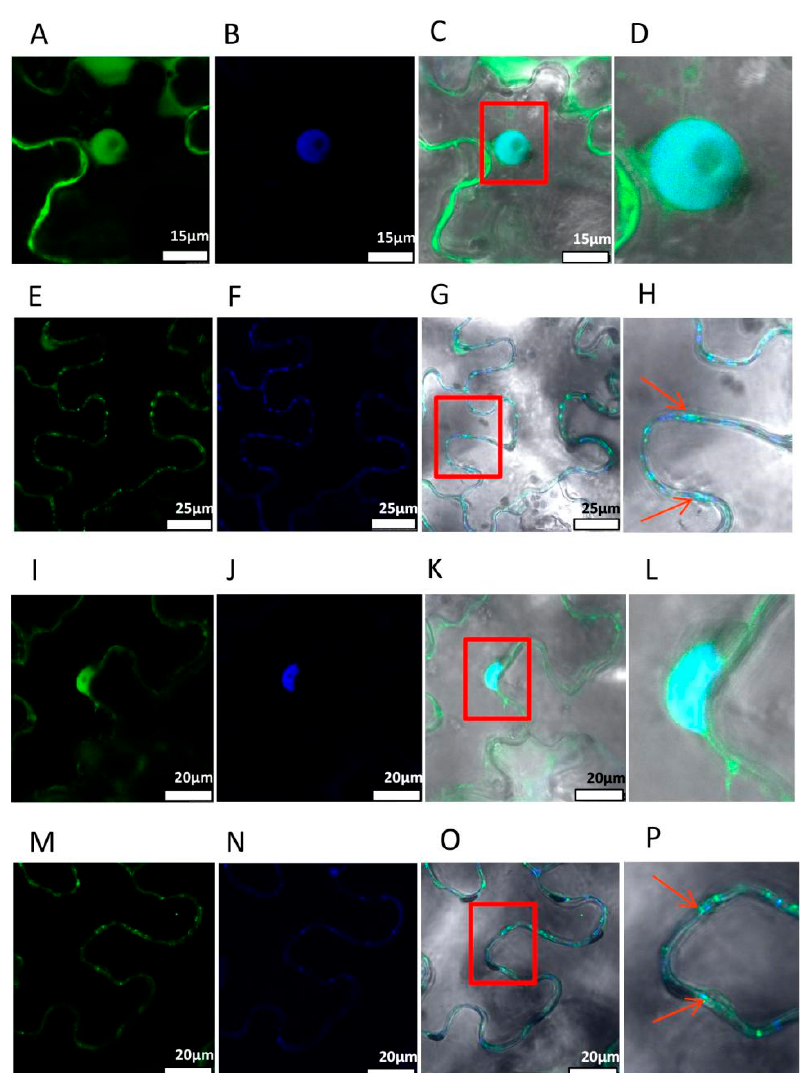
Figure 3. Subcellular localization of CTV-N4p23 and T36p23. ( A ) GFP-N4-p23 nuclear green fluorescence. ( B ) Nucleus excited in UV region and marked by blue fluorescence. ( C ) Overlap of two fluorescence signals. ( D ) Magnified view of overlap (red box in C). ( E ) GFP-N4p23 PD green fluorescence. ( F ) PD excited in the UV region and marked by blue fluorescence. ( G ) Overlap of two fluorescence signals. ( H ) Magnified view of overlap (red box in G); arrow indicates overlapping PD. ( I ) GFP-T36p23 nuclear green fluorescence. ( J ) Nucleus excited in UV region and marked by blue fluorescence. ( K ) Overlap of two fluorescence signals. ( L ) Magnified view of overlap (red box in K). ( M ) GFP-T36-p23 PD green fluorescence. ( N ) PD excited in UV region and marked by blue fluorescence. ( O ) Overlap of two fluorescence signals. ( P ) Magnified view of the overlap (red box in O); the arrow indicates overlapping PD.